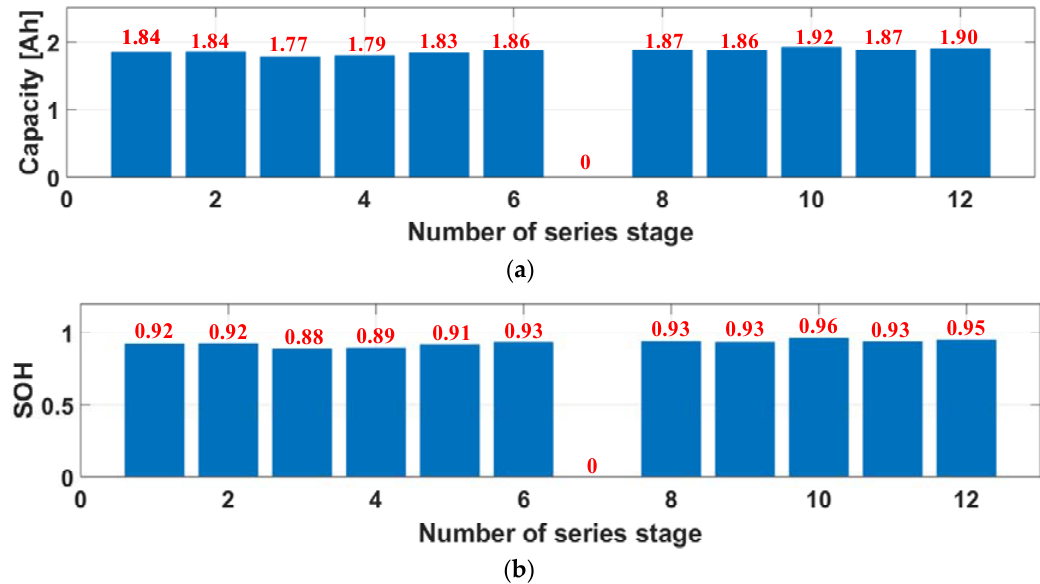
Figure 21. Discharge capacity and SOH of the 12 series-connected stages of the disassembled retired series/parallel battery pack using a full discharge/charge test (7S series stage of the short circuit): ( a ) discharge capacity and ( b ) SOH.